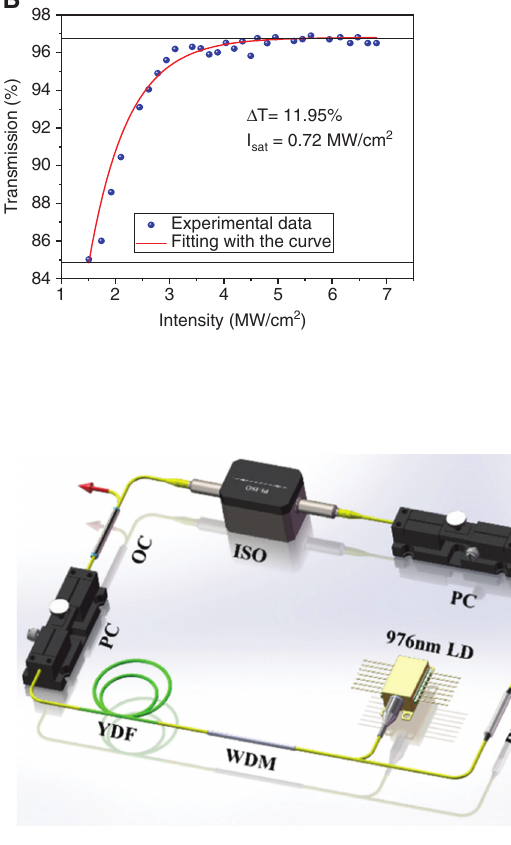
Figure 3: Schematic of ytterbium-doped fiber laser